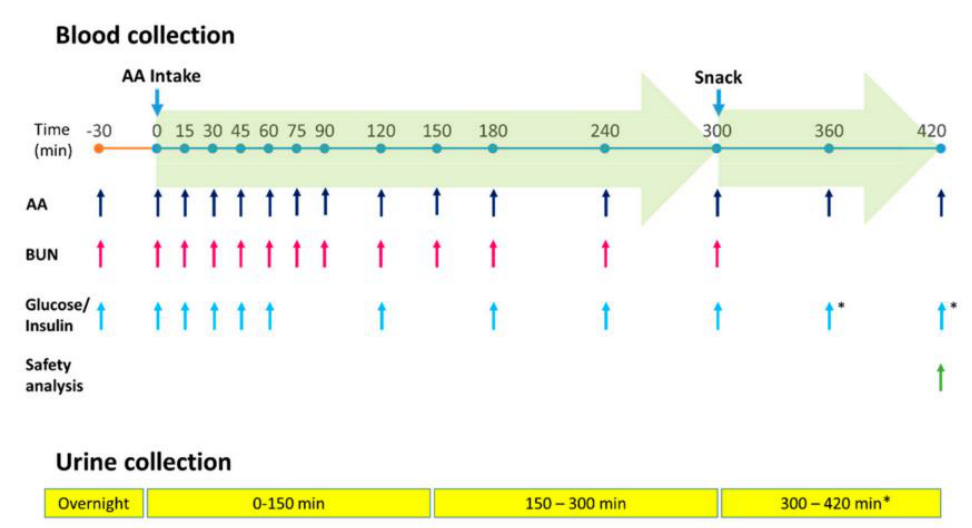
Figure 2. Administration, sample collection, and analysis schedule. AA, amino acids; BUN, blood urea nitrogen. * for safety assessment only.